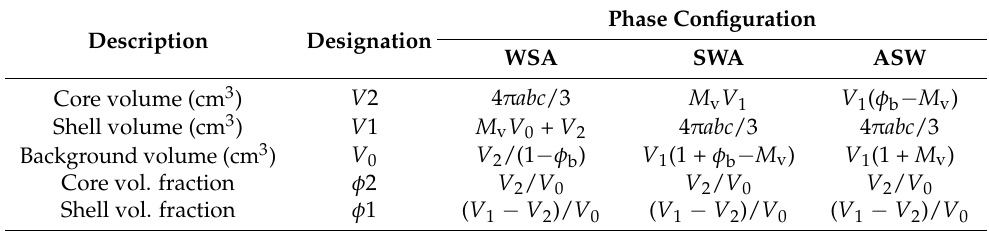
Table 9. Calculation of volumetric fractions of core ( ε 2 ), shell ( ε 1 ) and background ( ε 0